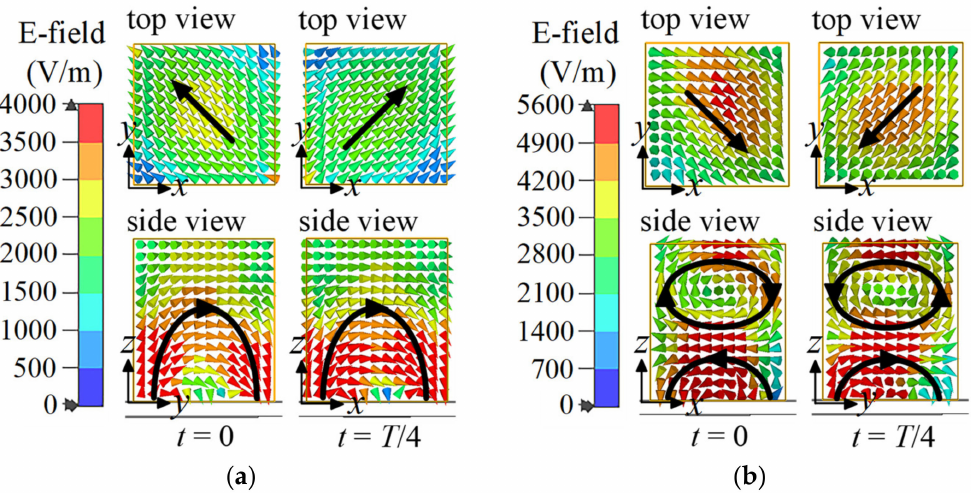
Figure 4. The distributions of the E -fields inside the DR: ( a ) 25 GHz at t = 0 and t = T /4; ( b ) 37 GHz at t = 0 and t = T